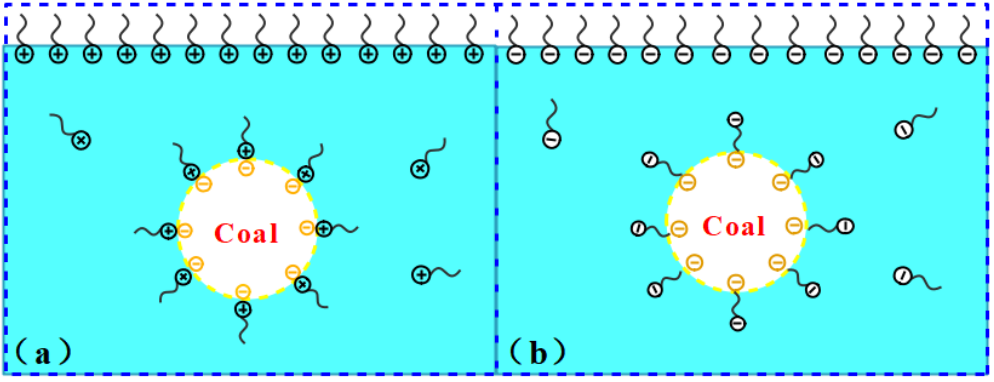
Figure 9. Schematic diagram of adsorption of surfactant on coal dust surface. ( a ) Schematic diagram of cationic surfactant adsorption on coal dust surface. ( b ) Schematic diagram of adsorption of anionic surfactant on coal dust surface.